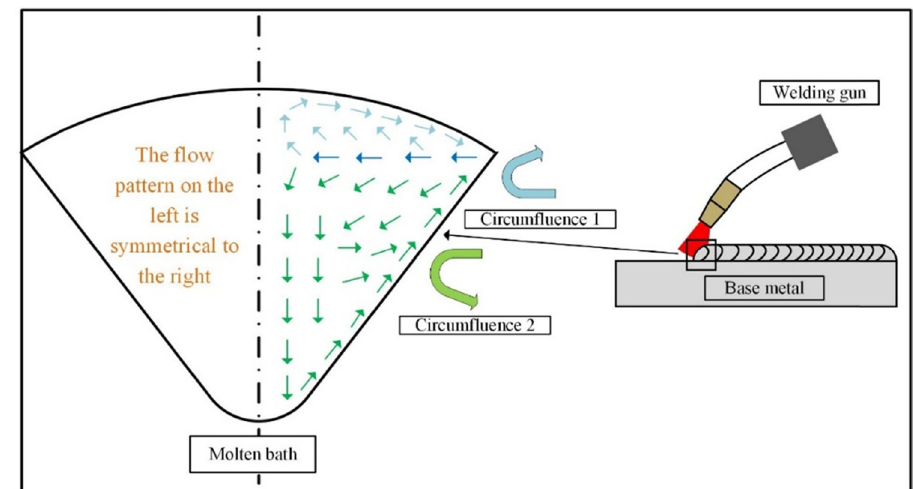
Figure 10: The flow direction of molten metal under